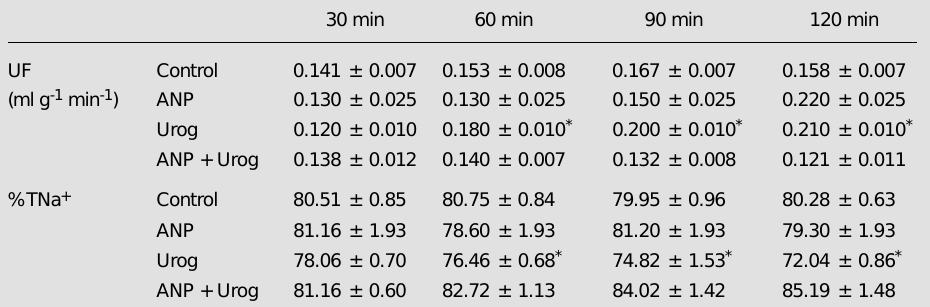
Table 1 - Comparison of the natriuresis (reduction in fractional sodium transport (%TNa + )) and diuresis (increase in urine flow (UF)) induced by uroguanylin (Urog), atrial natriuretic peptide (ANP), uroguanylin plus ANP (ANP + Urog) and control. Data are reported as means ± SEM. *P<0.05 (Fisher test, N ‡ 9). The previous introduction of ANP into the system blocked the uroguanylin-induced increase in UF and the decrease in %TNa + (natriuretic